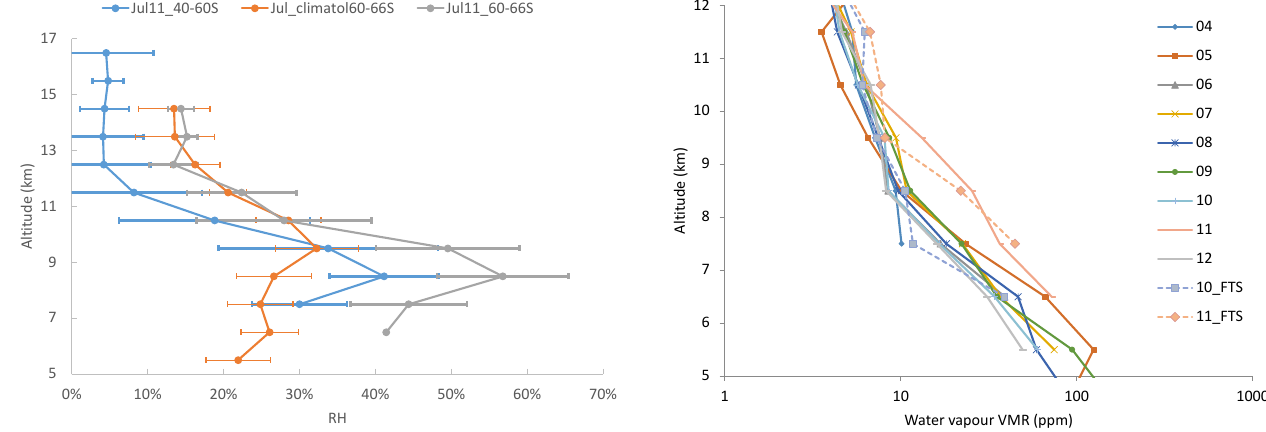
Figure 8. Southern high-latitude (60–90 ◦ S) monthly median wa- ter vapour profiles in July for different years. MAESTRO: 2004– 2012; ACE-FTS: 2010 ( N = 169) and 2011 ( N = 176). A logarith- mic scale is used for the x axis. The number of July profiles (60– 90 ◦ S) for MAESTRO is 96 per year on